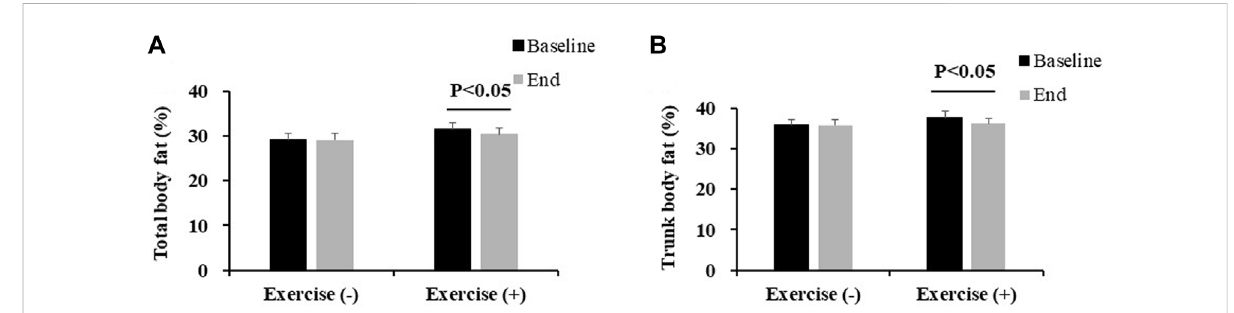
FIGURE 4 Effectofexercisetrainingonbodyfatpercentage (A) andtrunkbodyfatpercentage (B)